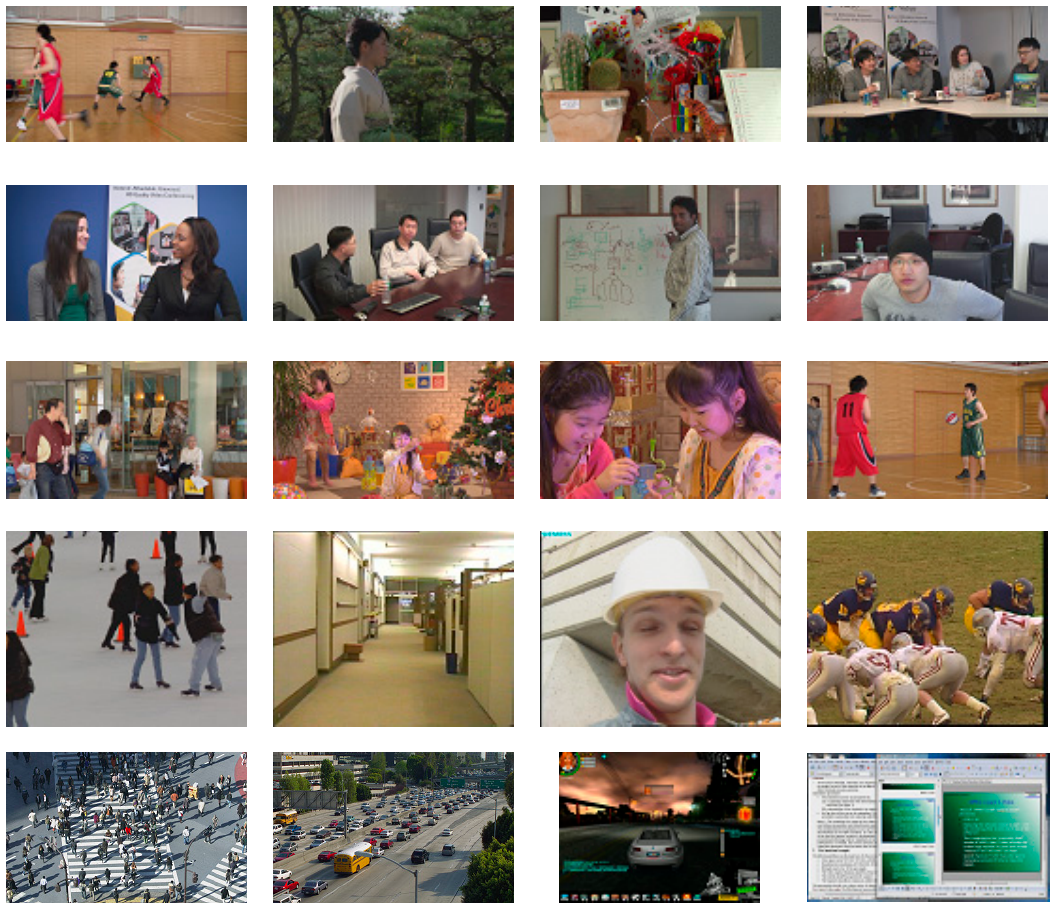
Figure 7. Illustration of the first frame of testing videos. From left to right, top to bottom: BasketballDrive, Kimono, Cactus, FourPeople, KristenAndSara, Vidyo1, Vidyo3, Vidyo4, BQMall, PartyScene, Ice, BasketballPass, BlowingBubbles, Hall, Foreman, Football, PeopleOnStreet, Trafic, ChinaSpeed, SlideEditing.